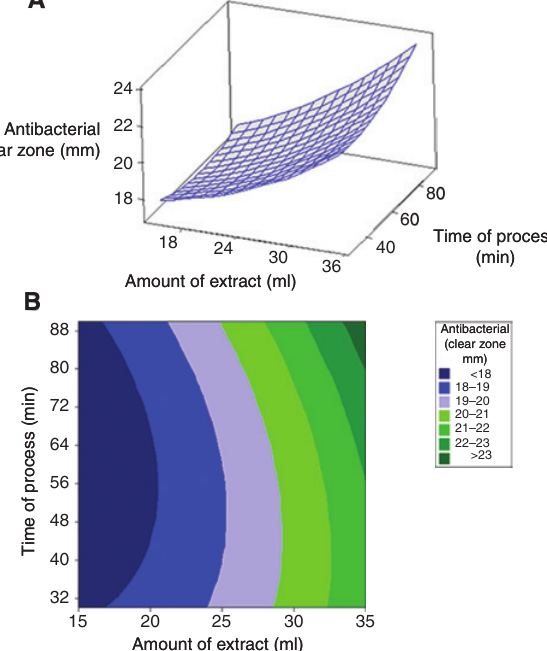
Figure 3: Response surface (A) and contour plots (B) for antibacte- rial ••• of ZnO NPs as a function of significant (p < 0.05) interaction effects of reaction time and amount of